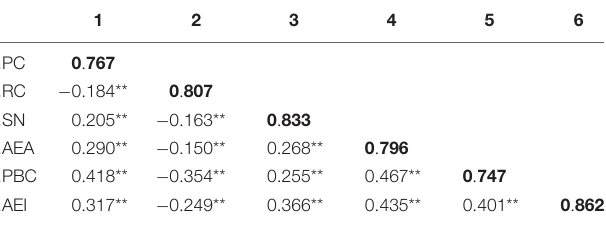
TABLE 4 | Correlation analysis.